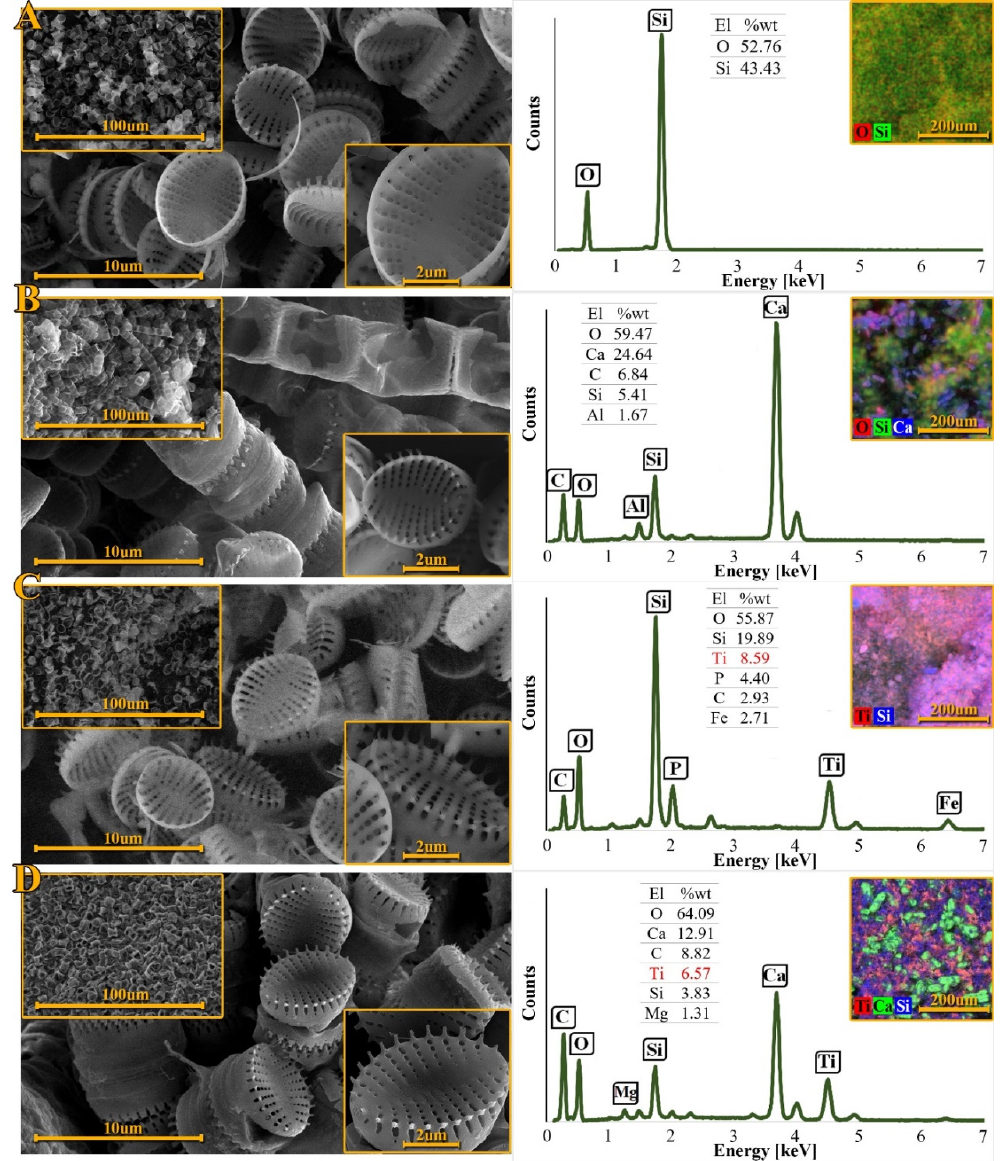
Figure 4. Review of SEM images and SEM-EDX spectra, elemental composition and distribution of titanium: ( A ) purified diatomaceous biosilica, ( B ) dried biomass, ( C ) diatomaceous biosilica doped with titanium ions, ( D ) diatomaceous biomass containing titanium.